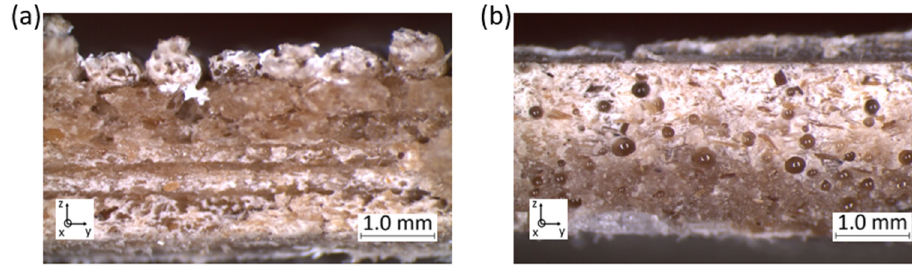
Figure 3. Fracture surface of a quasi-isotropic specimen: ( a ) as-printed ( b ) post-processed.